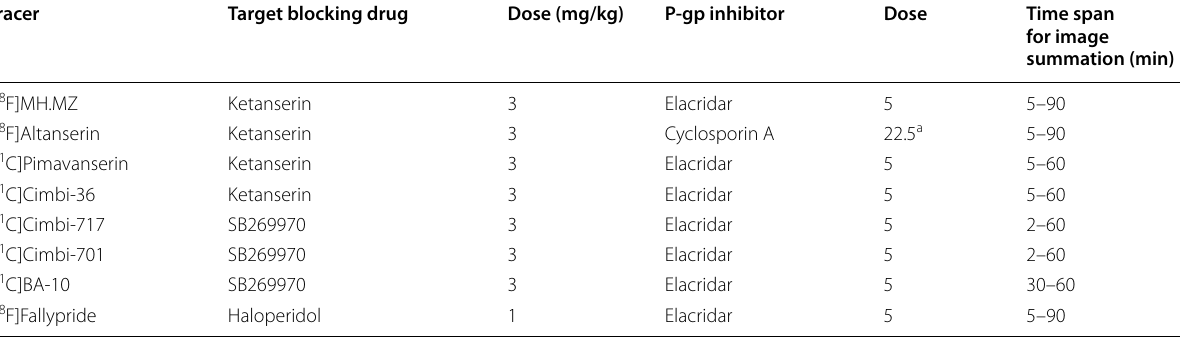
a After bolus injection of 22.5 mg/kg cyclosporin A, rats received constant infusion of 7.5 mg/kg/h